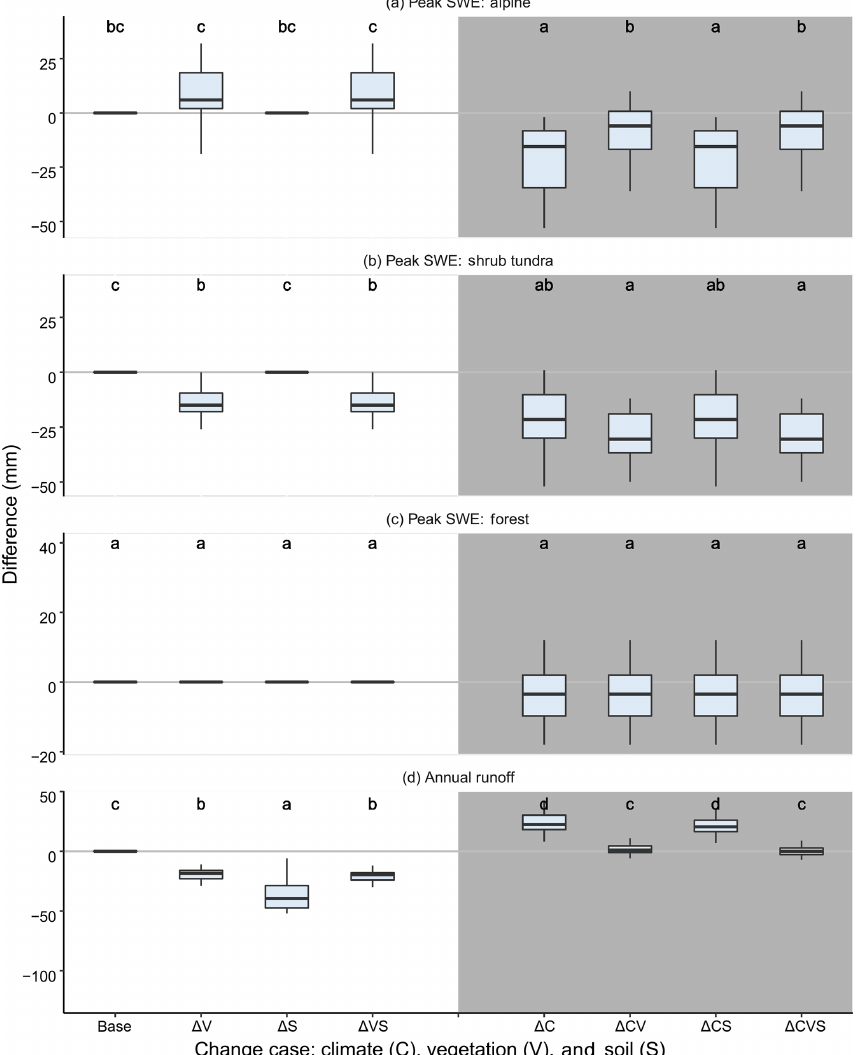
Figure 3. Differences in peak snow water equivalent (SWE) and annual runoff volume under seven combinations of changes in climate, vegetation, and soil in the Wolf Creek Research Basin relative to present climate, present vegetation, and present soil with no change (base). Lower case letters from the Tukey HSD test indicate groups that are significantly different from each other. The unshaded cases on the left- hand side of the plot demonstrate changes under modeled present climate, and the shaded cases on the right-hand side of the plot demonstrate vegetation and soil changes under modeled future-climate